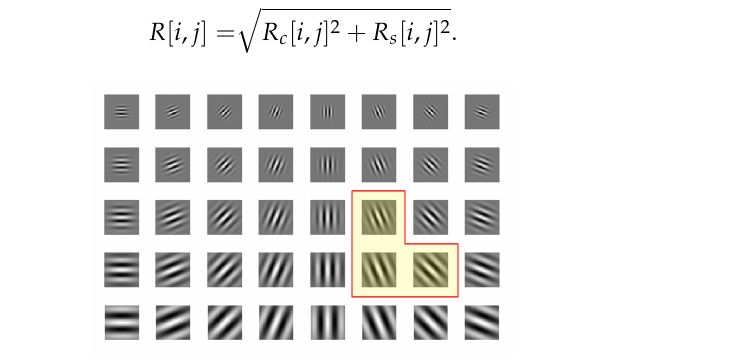
Figure 1. Real parts of the Gabor filter bank used in the experiments in this paper according to the different orientations and scales. Highlighted are the filters giving the highest contribution to the detection to be described in next